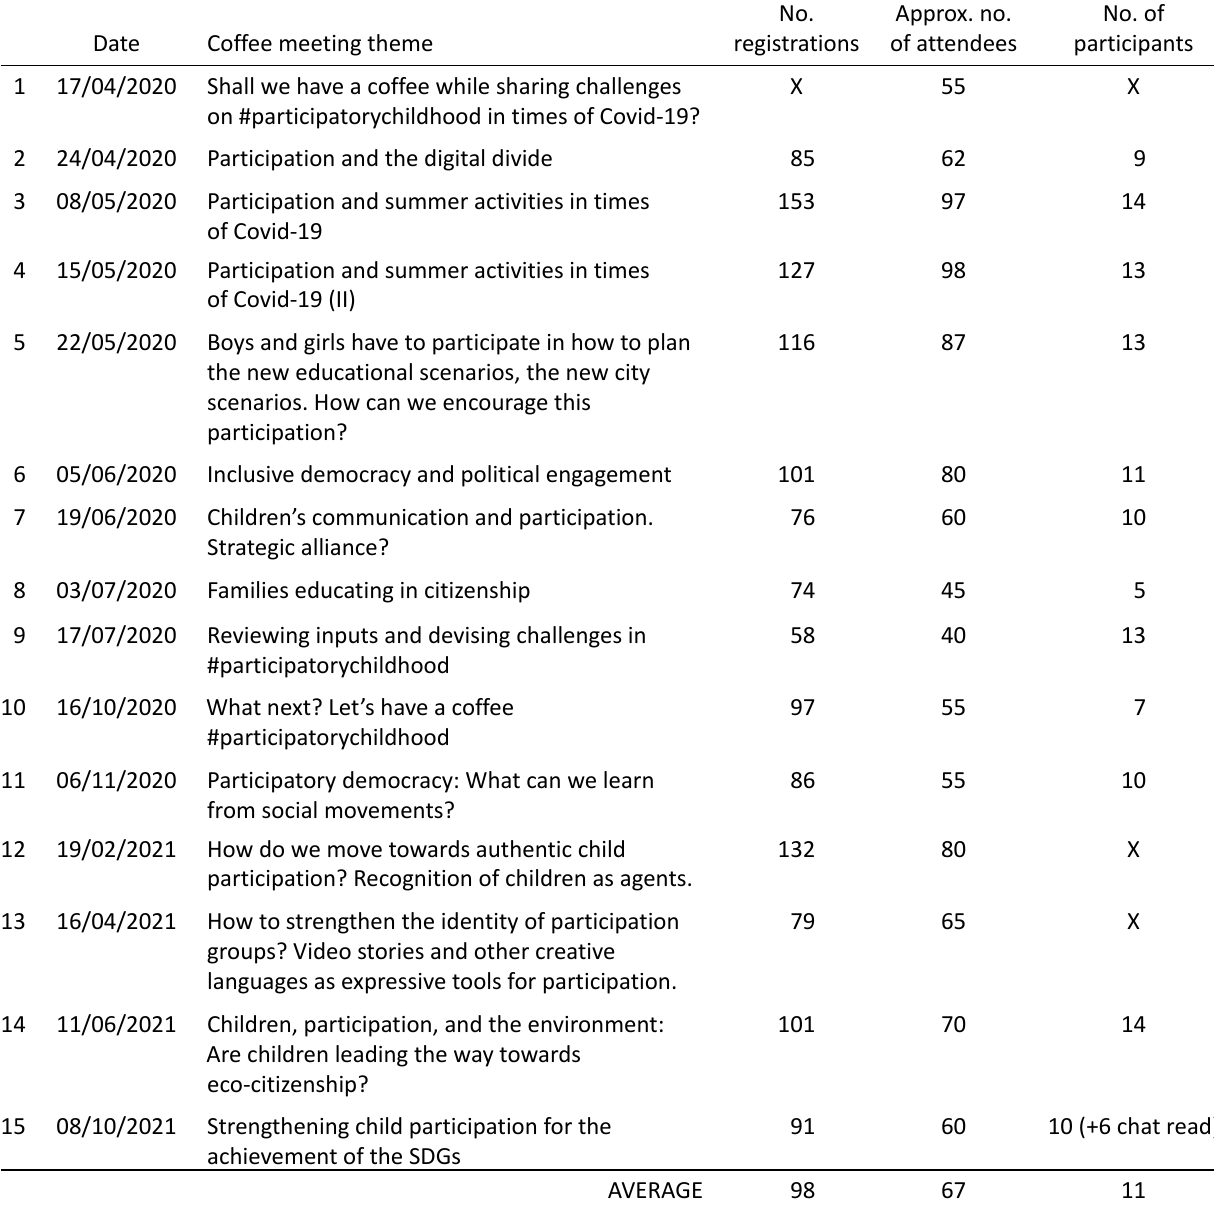
Table 1. Regularity of the meeting, topics addressed, registrations, and attendance.